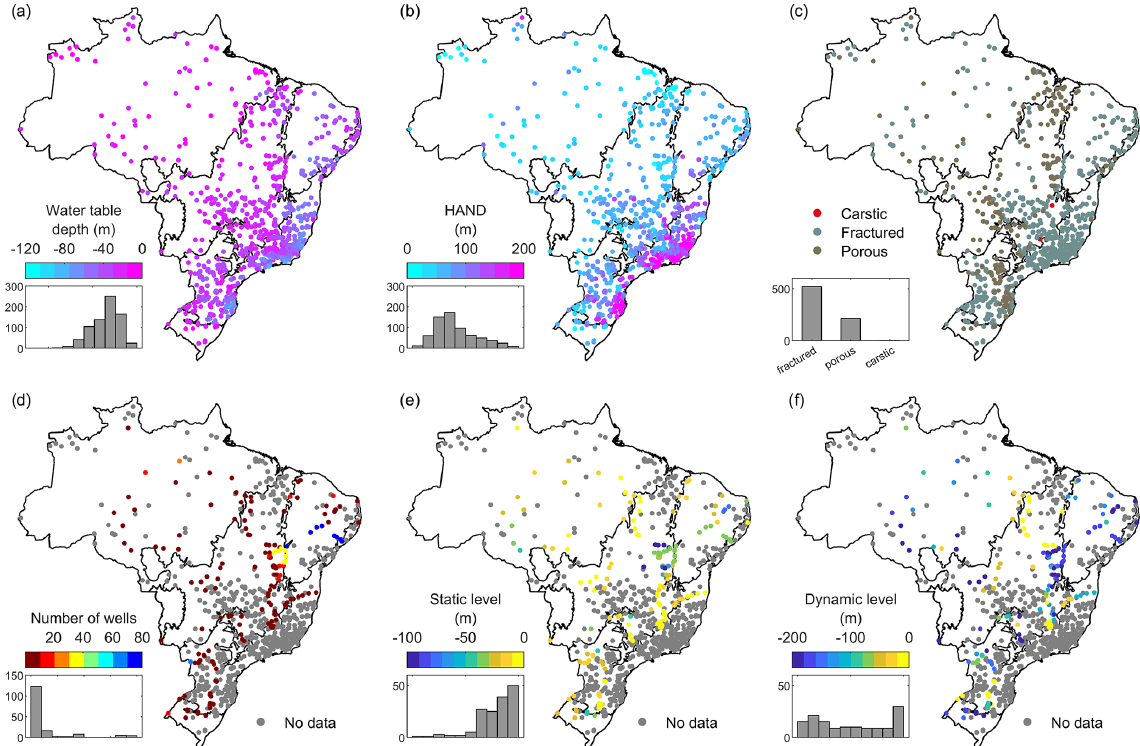
Figure 8. Spatial distribution of the groundwater attributes of the CABra catchments. (a) Water table depth (in m); (b) height above the nearest drainage (in m); (c) type of aquifer bedrock; (d) number of experimental wells; (e) static level (in m); (f) dynamic level (in